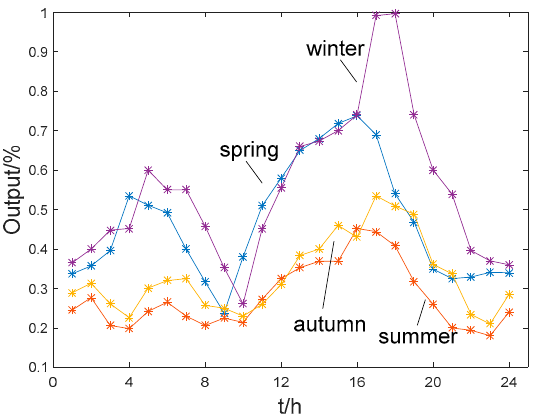
Figure 3. Wind turbine generators (WG) timing characteristics curve.